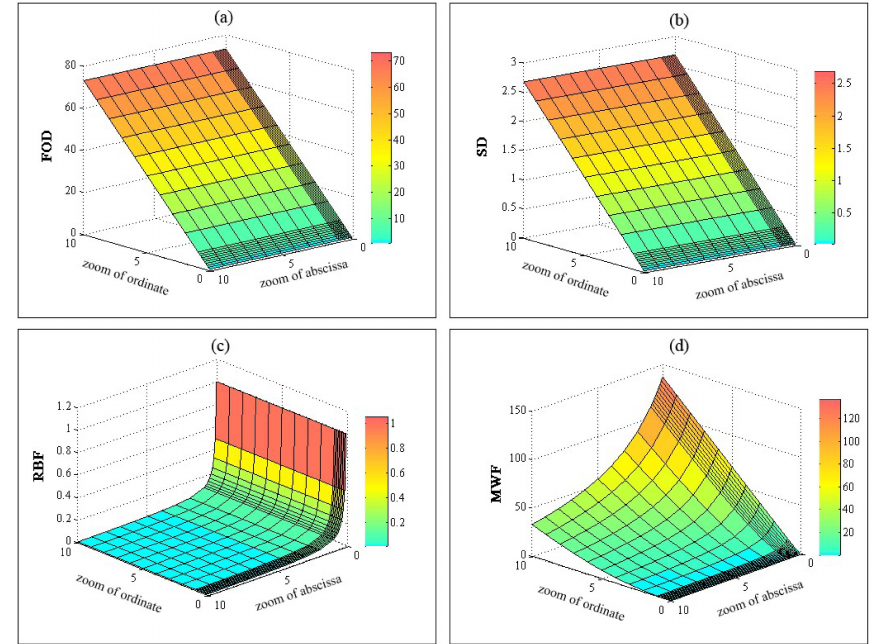
Figure 9. Comparison of indices with different zoom patterns. ( a ) the FOD index; ( b ) the SD index; ( c ) the RBF index; ( d ) the MWF